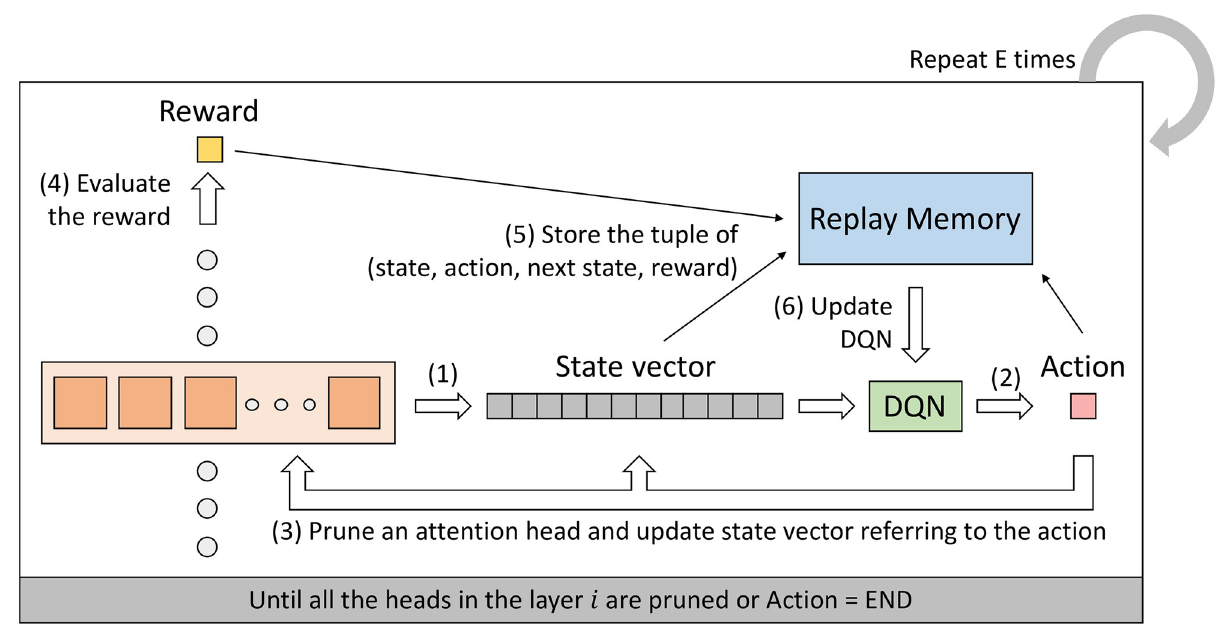
Fig 3. Overall flow of training AUBER on a layer. AUBER trains DQN to find out the attention heads that should be pruned for a better regularization following the illustrated steps.